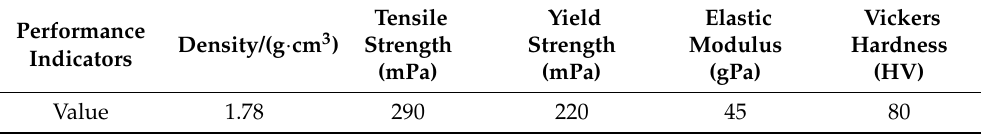
Table 2. Performance of AZ31B Magnesium Alloy [13].